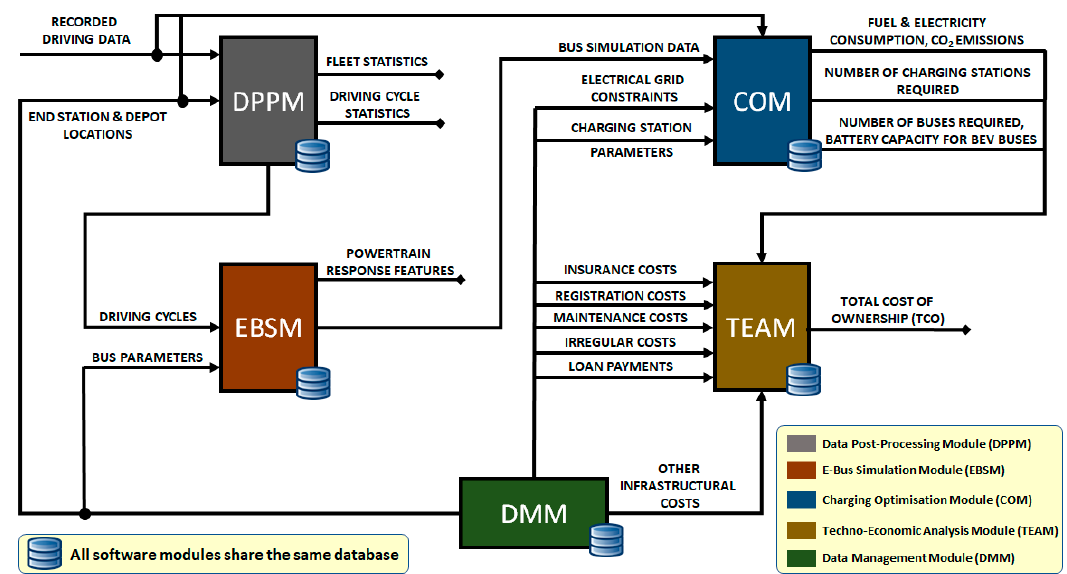
Figure 2. Organisational structure of simulation tool.